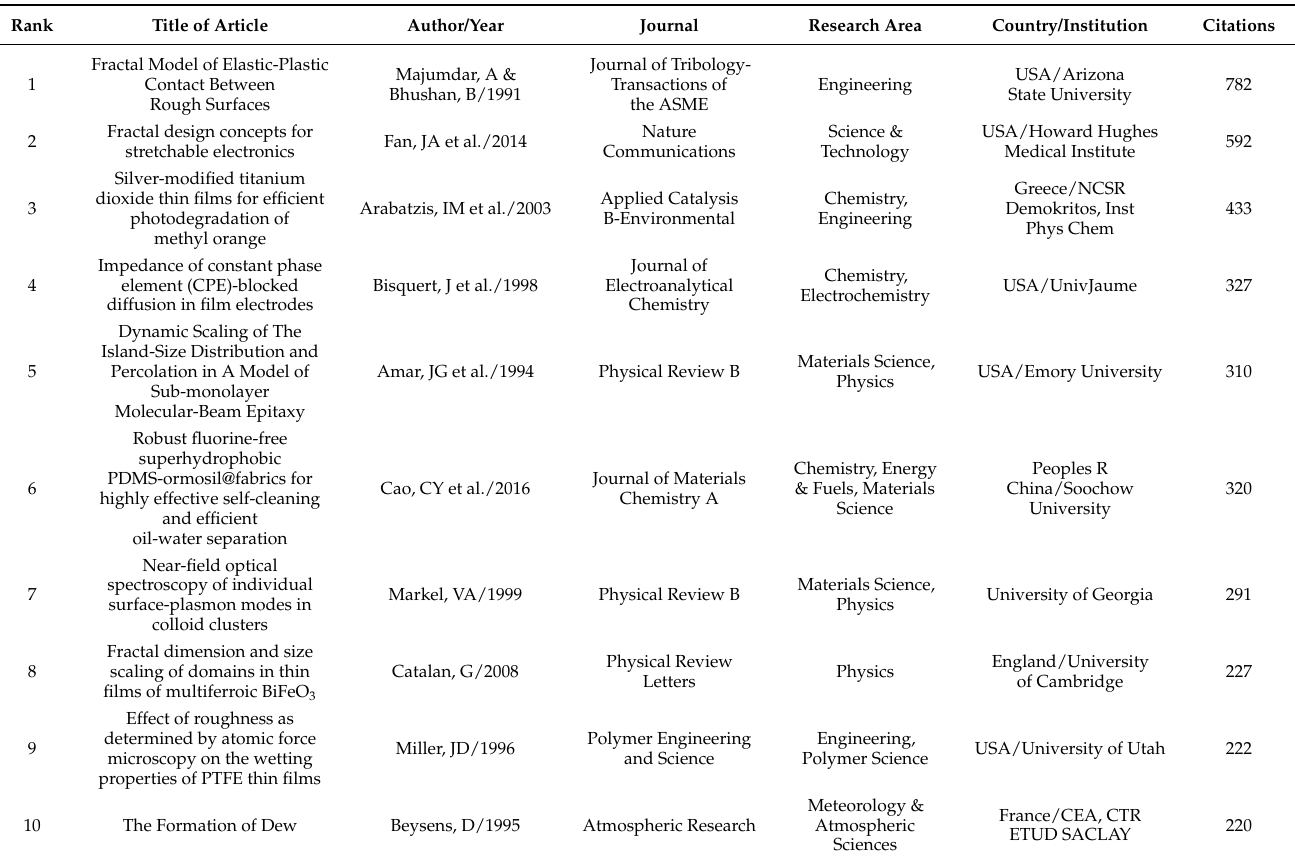
Table 1. The bibliographic details of the ten leading articles (highest citations) on fractal theory in thin film